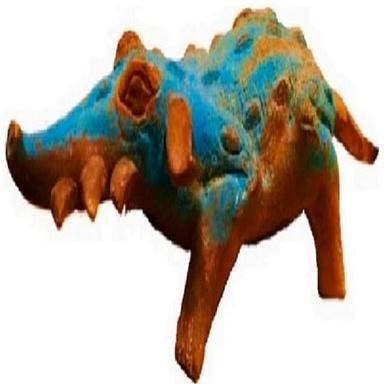
Crocodile-shaped rattle pottery using Maya Blue pigment for surface decoration (Maya culture; 8th century; The Michael C. Rockefeller Memorial Collection, Metropolitan Museum of Art, MET (The Metropolitan Museum of Art), photo by Eduardo Ruiz-Hitzky). (For interpretation of the references to colour in this figure legend, the reader is referred to the web version of this article.)